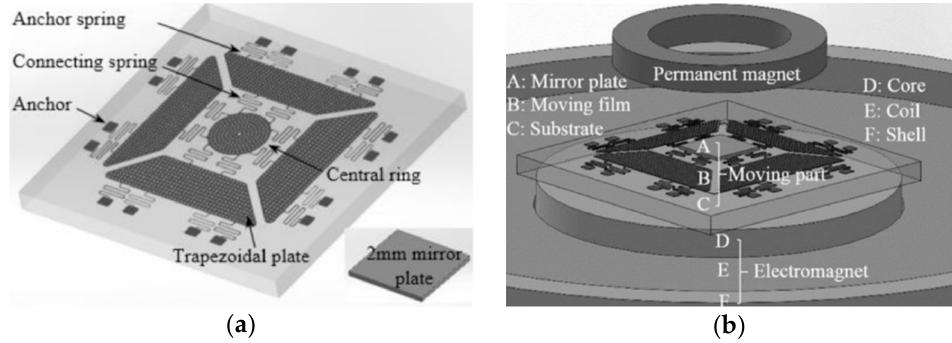
Figure 24. Concept of the micromirror: ( a ) Moving film of the micromirror; ( b ) structure of the micromirror. (Reprinted with permission from Reference [48] IOP Publishing, Ltd.).